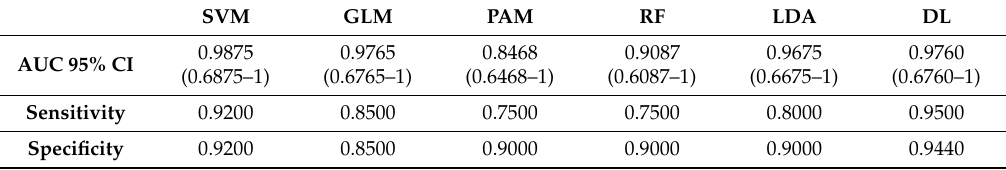
Table 2. Results of CP AI / DL predictions based on the top 230 individual CpG